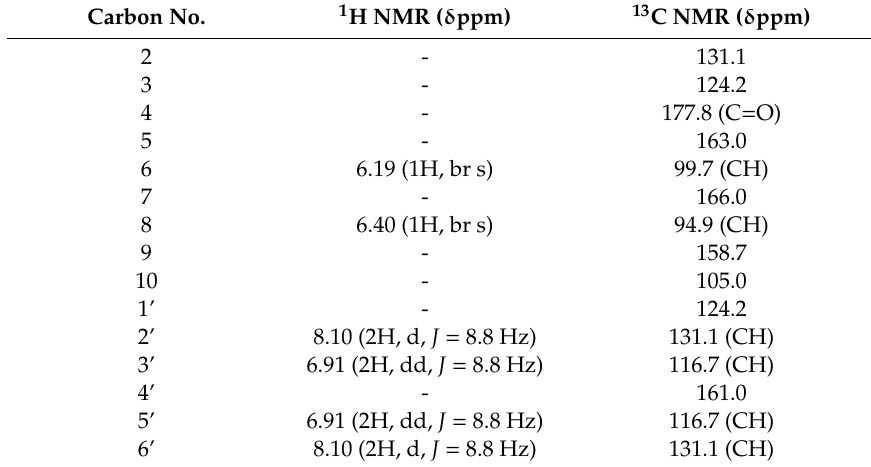
Table 1. The 1 H and 13 C NMR spectral data (recorded in CD 3 OD) of BV1 fraction isolated from Bauhinia variegata L. bark. Carbon